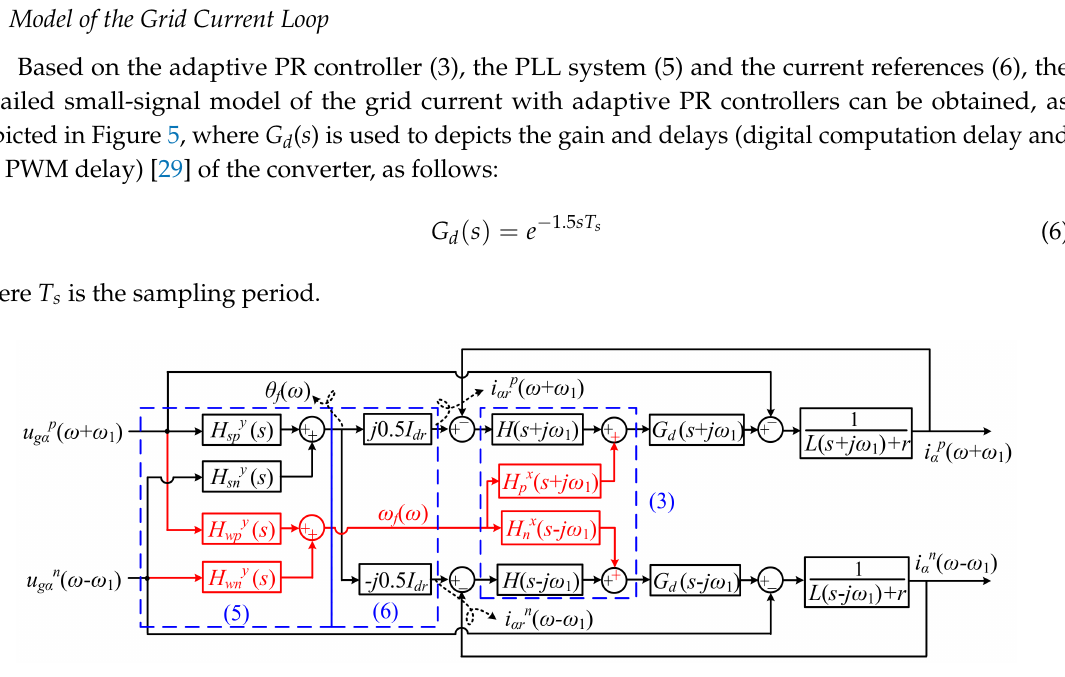
Figure 5. Small signal model of grid current control loop influenced by the PLL